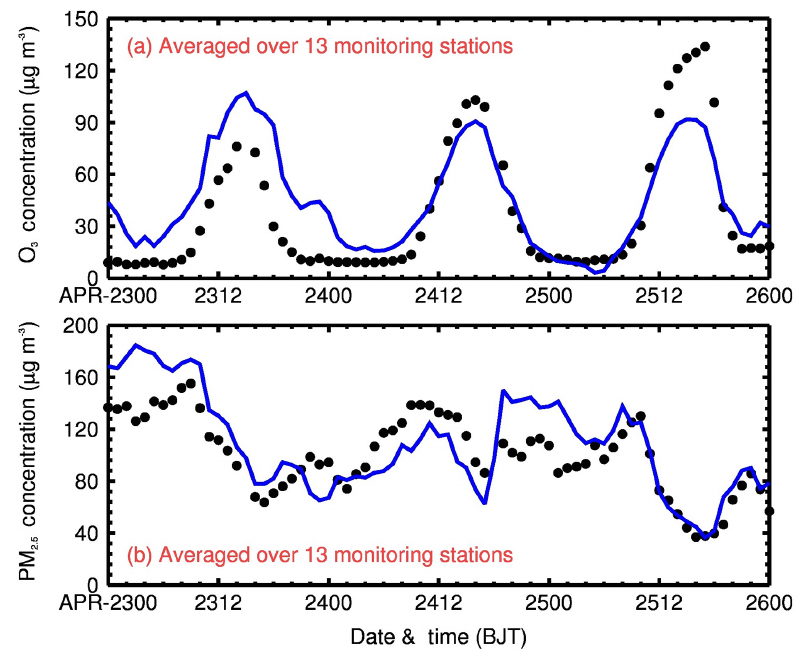
Figure 7. Temporal variations of simulated (blue line) and observed (black dots) (a) O 3 and (b) PM 2 . 5 concentrations averaged over 13 mon- itoring sites in Xi’an and surrounding areas from 23 to 25 April 2013.